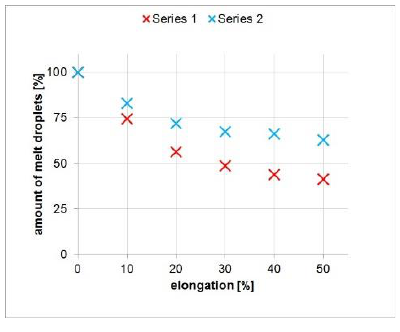
Figure 1. Detachment behavior of melt droplets caused by pre-deformation [20].